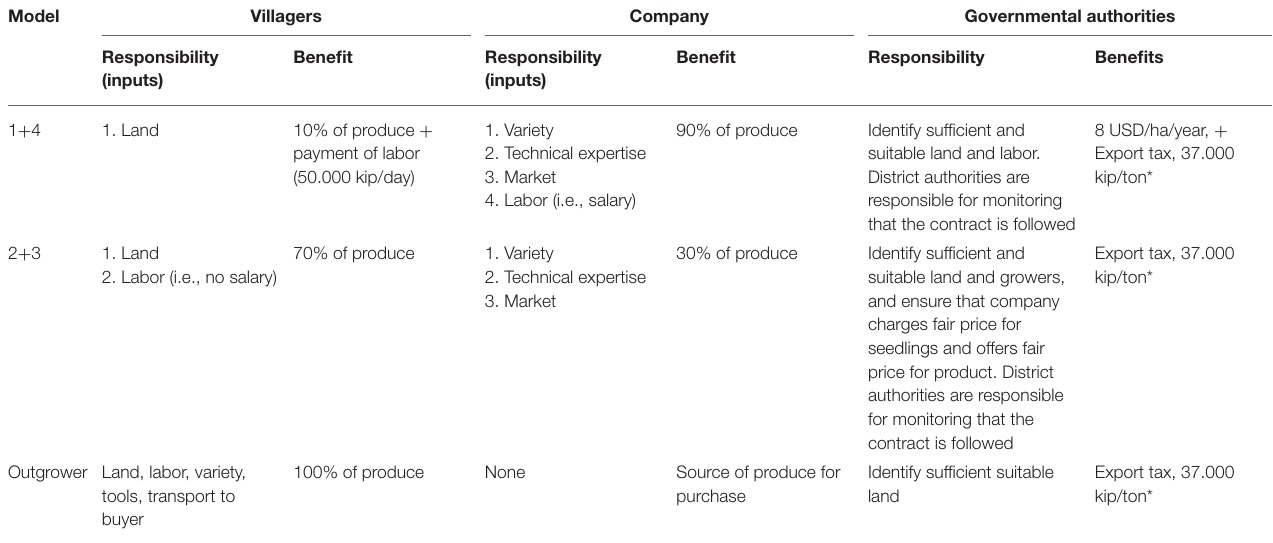
TABLE 2 | Production models contemplated in the biofuel and industrial plantation.